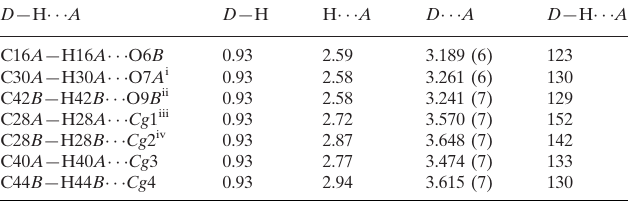
Hydrogen-bond geometry (A˚ , (cid:2)